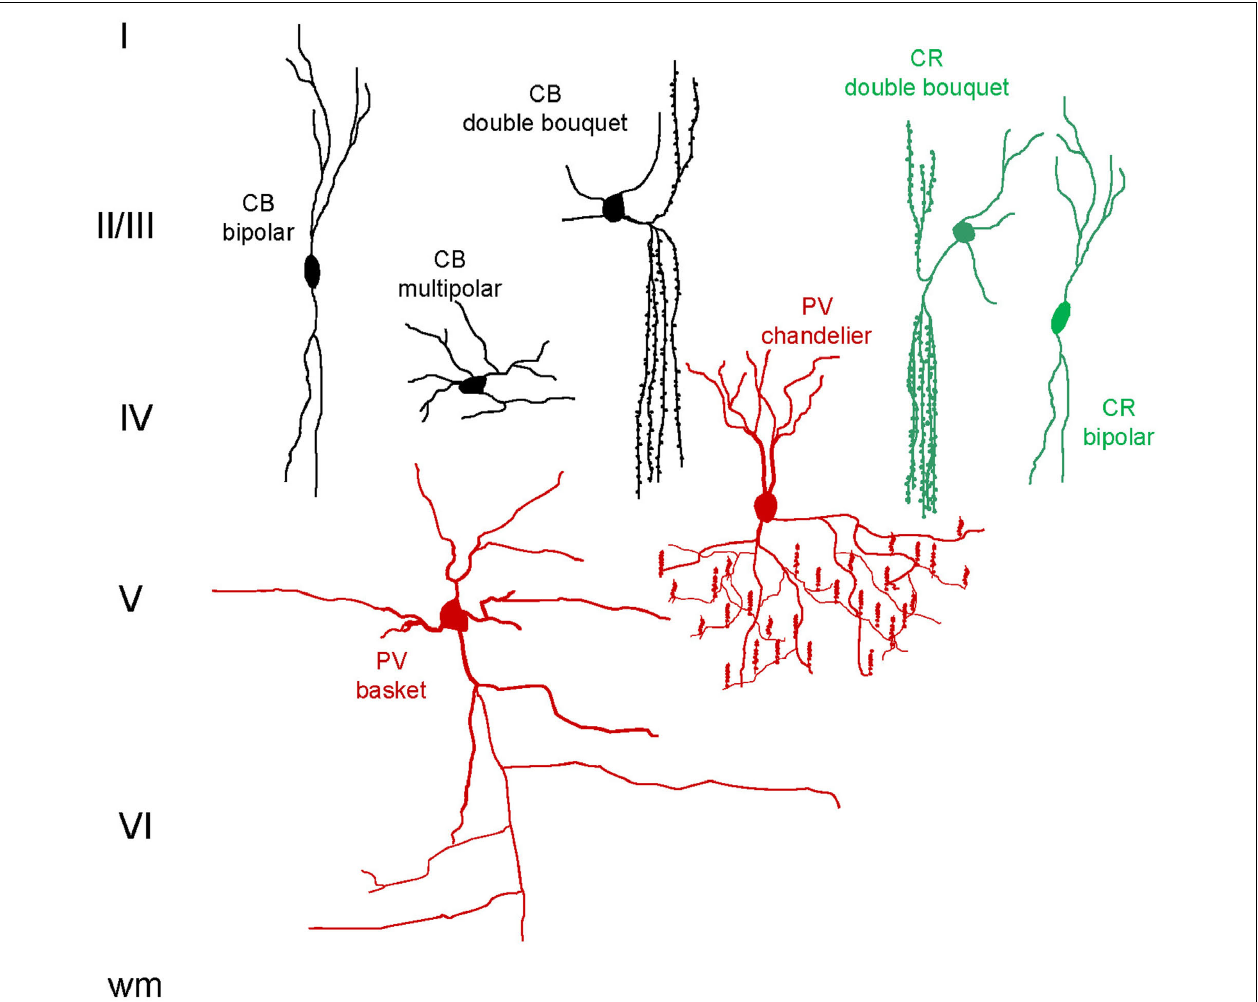
FIGURE 2 | Schematic representation of the major calcium-binding protein-ir interneuron subtypes. Roman numerals indicate cortical layers, wm = white